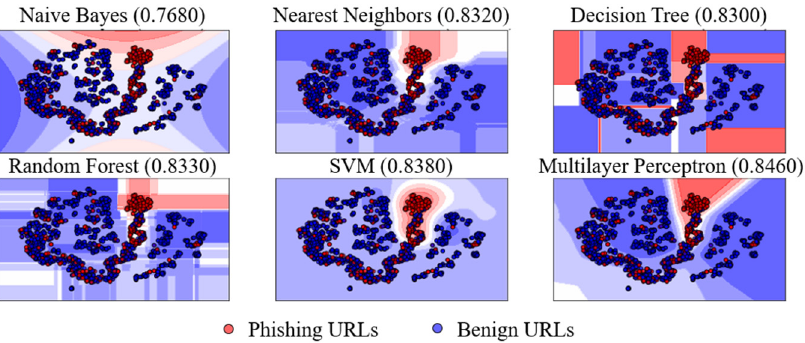
Figure 1. Class imbalance issue addressing the limitations of the supervised learning approach in the field of phishing URL modeling.